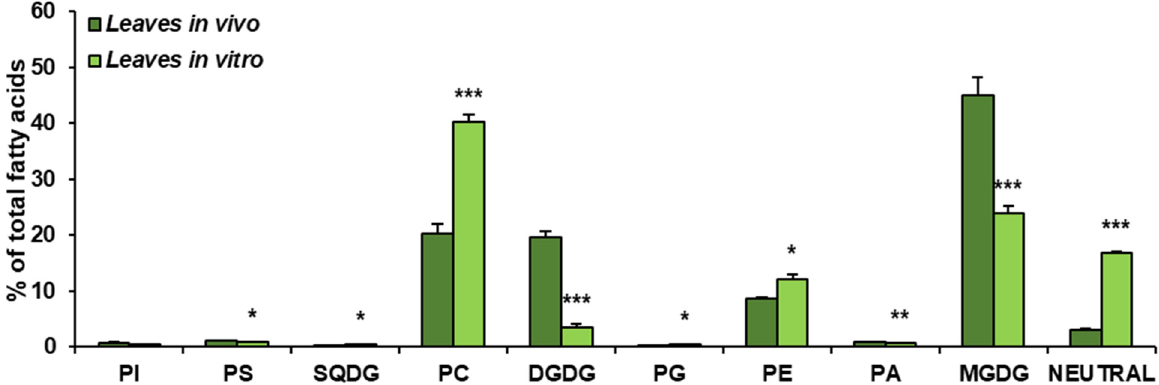
Figure 3. Lipid classes present in C. sativa leaves cultured in in vivo and in vitro conditions. Mean values and SD are presented (data from at least three independent assays). Asterisks indicate significant difference between relative amounts of each lipid class of leaves cultivated in vivo and in vitro in a two-tailed Student’s t -test: * p ≤ 0.05, ** p ≤ 0.01, *** p ≤ 0.001.